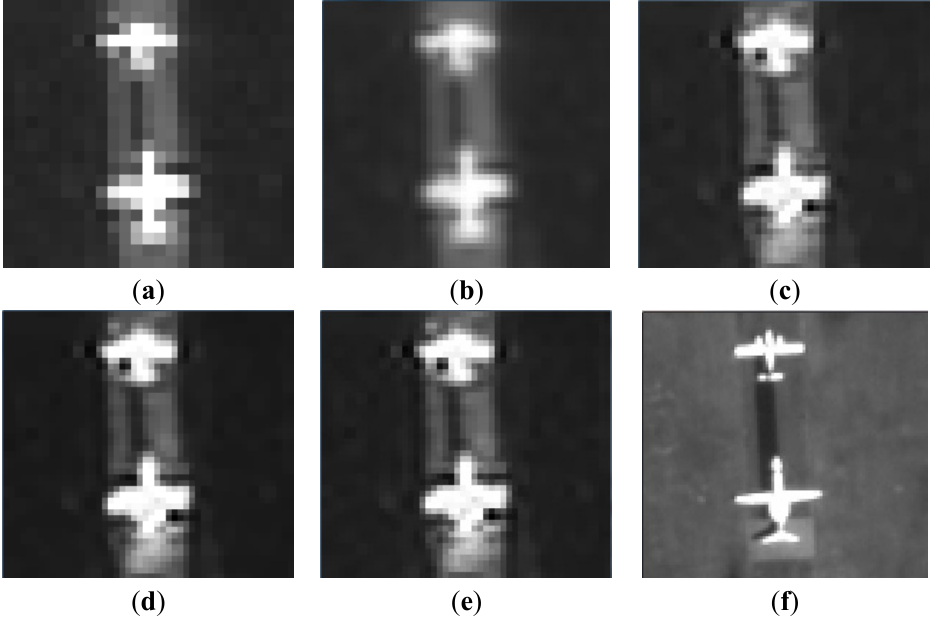
Figure 12. Local amplification 2 of the real experiment result shown in Figure 9. ( a ) LR reference image; ( b ) bilinear interpolation; ( c ) GEN; ( d ) ANGW; ( e ) RESW; ( f ) panchromatic